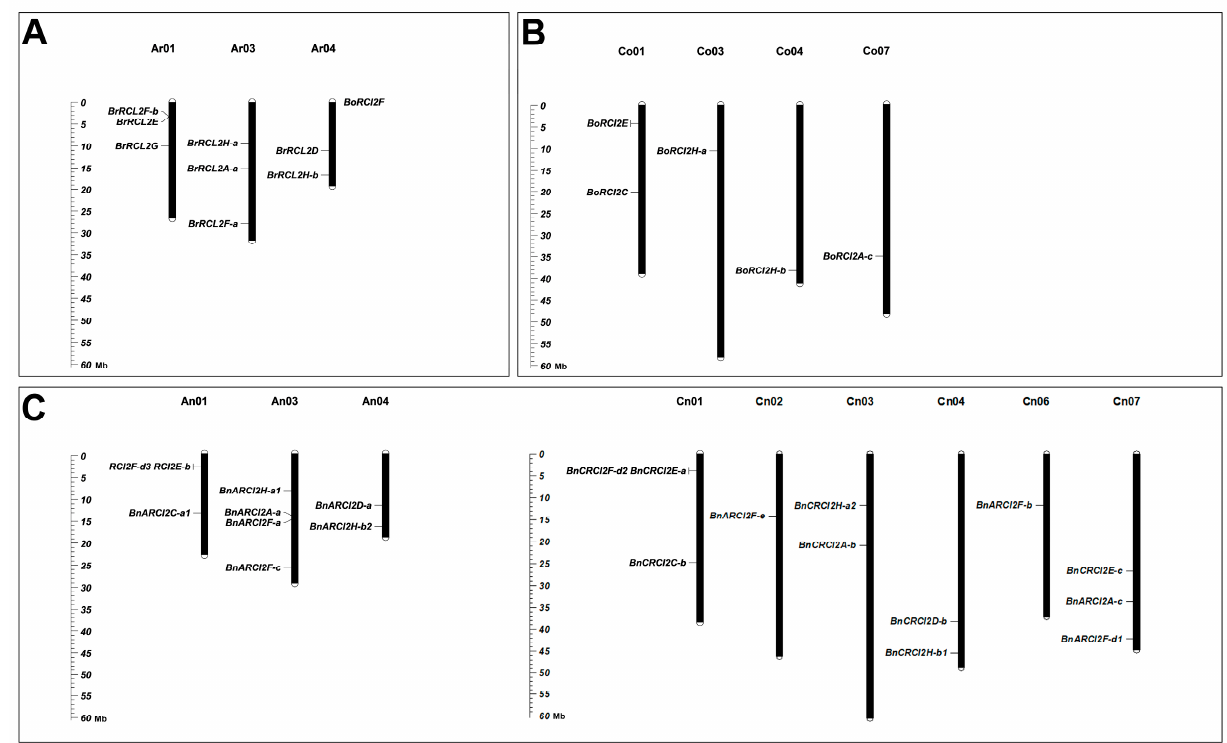
Figure 2. The chromosomal location of the RCI2 gene family in B. rapa ( A ), B. oleracea ( B ) and B. napus ( C ).